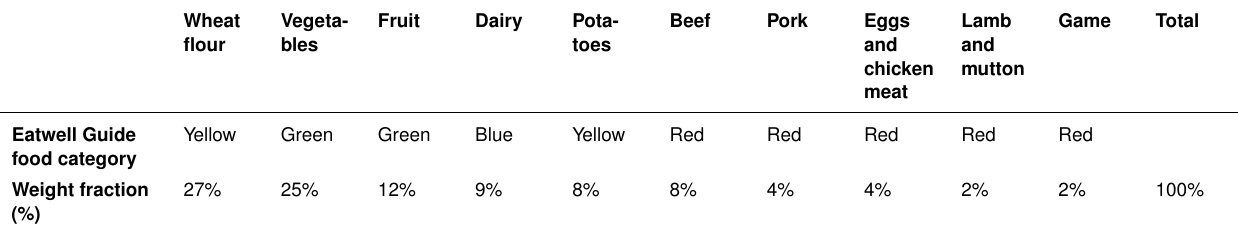
Table 4. Food types produced in this study: Eatwell Guide [12] food category and weight